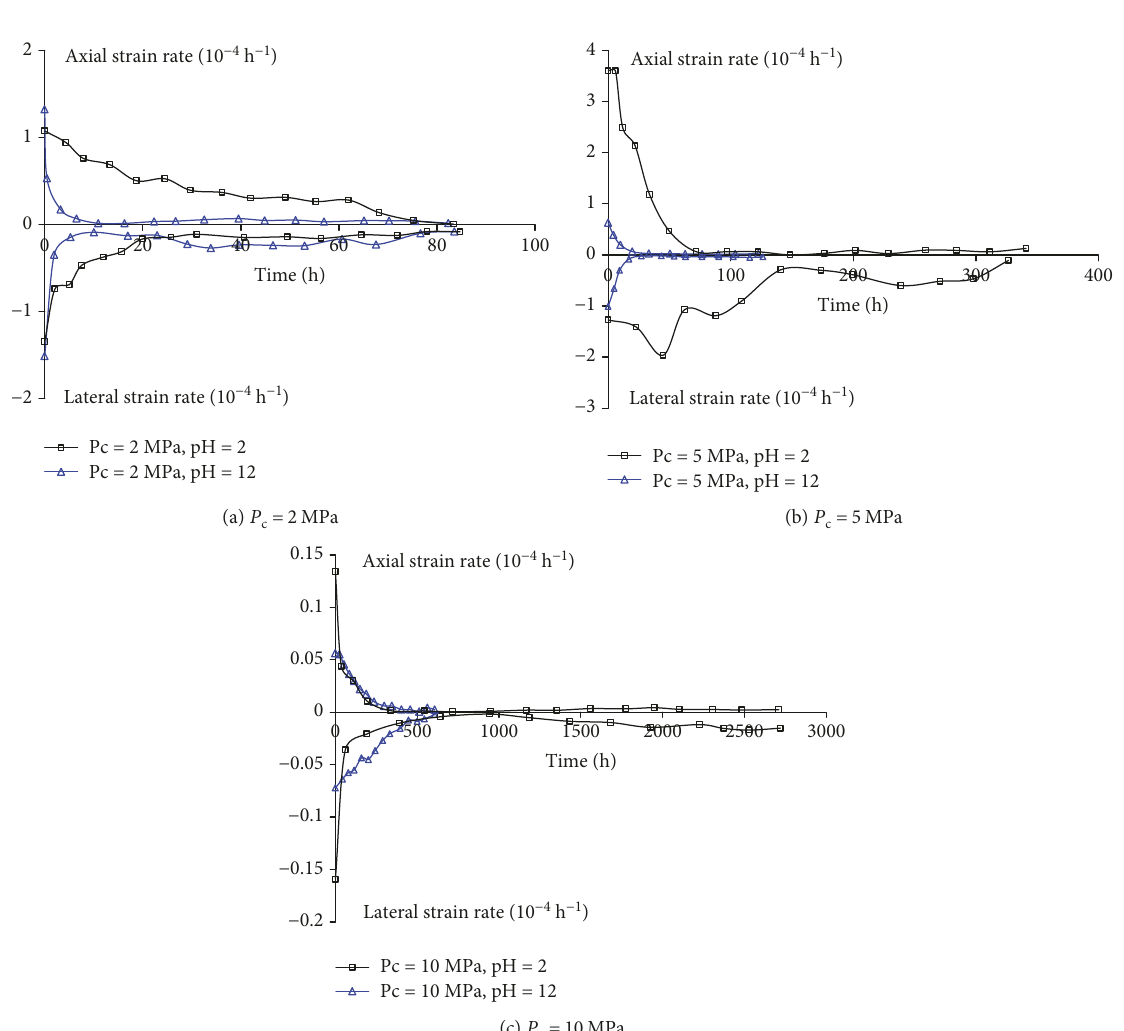
Figure 6: Creep strain rate evolutions of the cracked samples under di ff erent con fi ning pressures and reactive solution